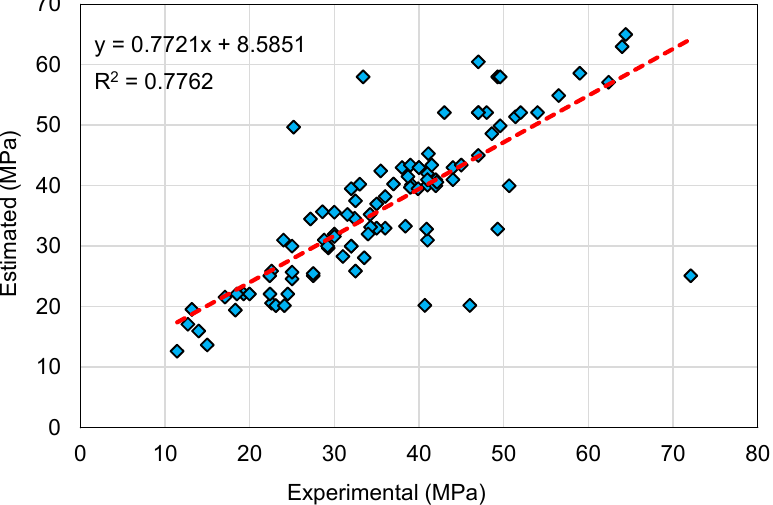
Figure 8. Relationship between experimental and estimated results for the support vector machine model.